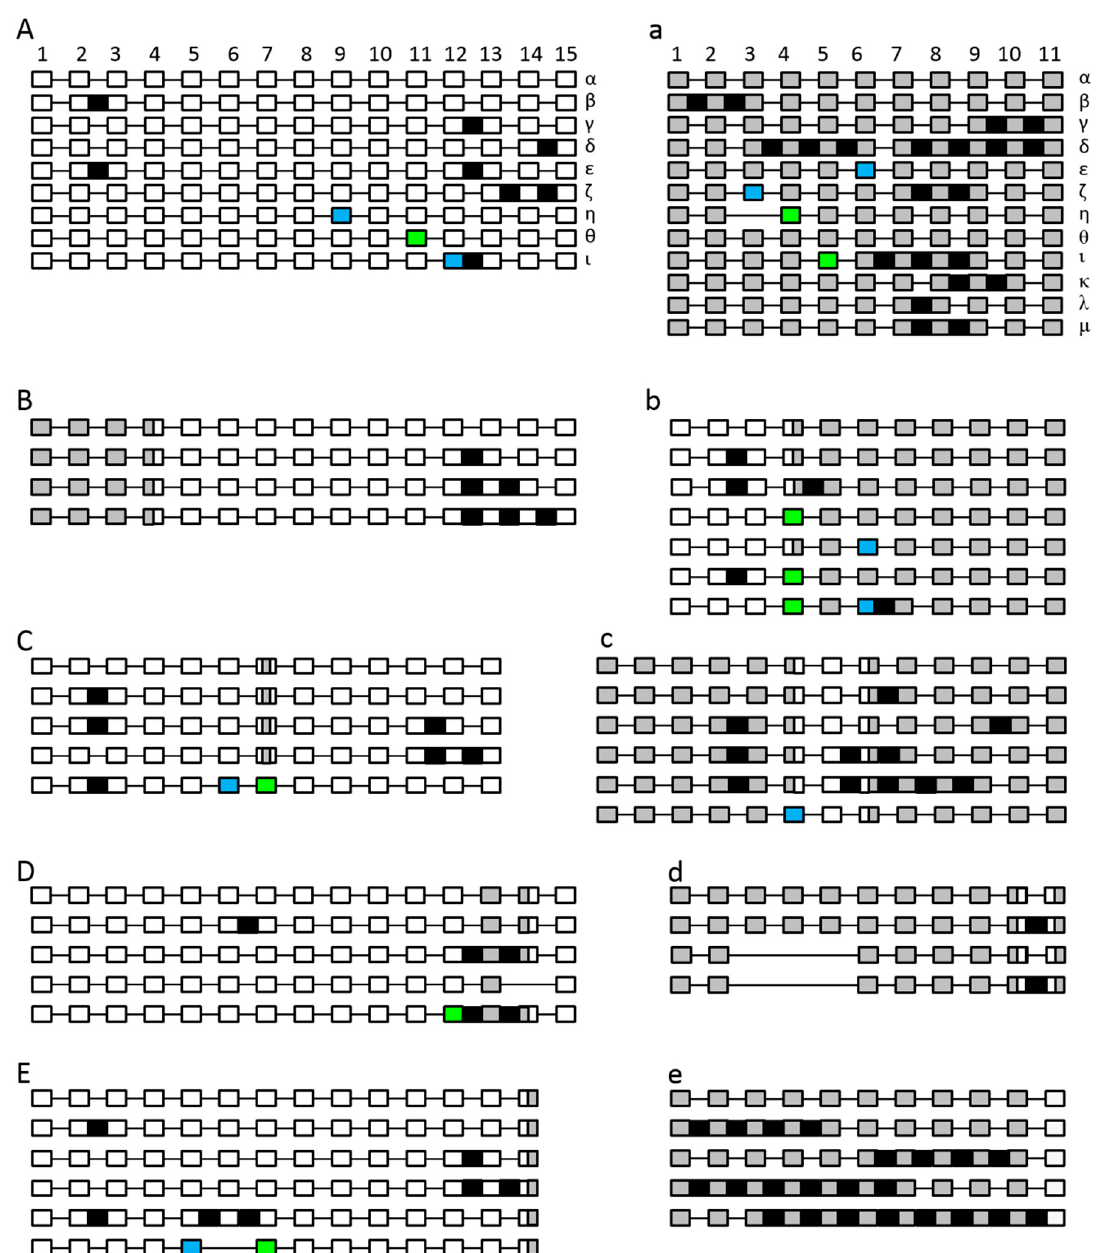
Figure 12. Schematic unscaled schema of the different splice forms of SPO11-1 ( A – E ) and -2 ( a – e ). Arabidopsis thaliana WT ( A , a ), Arabidopsis thaliana Swap1 ( B , b ), Arabidopsis thaliana Swap2 ( C , c ), Arabidopsis thaliana Swap3 ( D , d ) and Arabidopsis thaliana Swap4 ( E , e ) reintegrated into Arabidopsis . Exons are numbered and shown as white (SPO11-1) or grey (SPO11-2) blocks, spliced introns as black lines. Intron retention events are illustrated as black boxes, alternative 5’splice site selections are shown as blue boxes and alterative 3’splice site selections as light green boxes. In the case of exon skipping, the corresponding white box is missing. Previously known splicing forms are named in Greek letters, see [33].